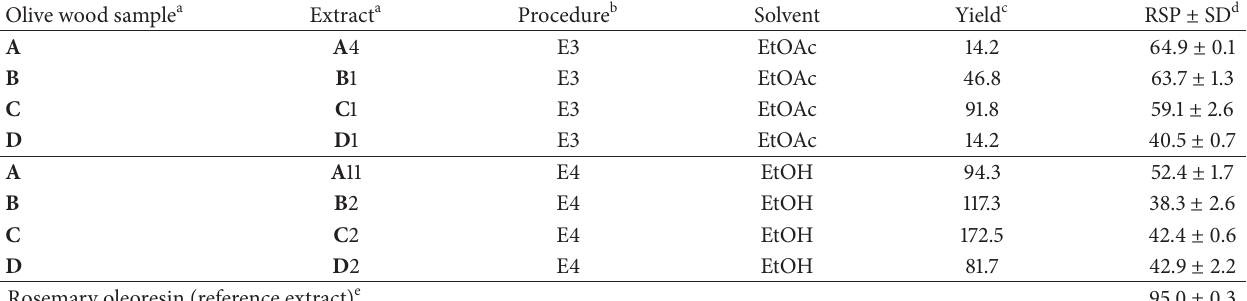
Table 4: Extraction yields and radical scavenging percentages of several extracts prepared by the extraction procedures E3 and E4 from olive wood samples A , B , C , and D .